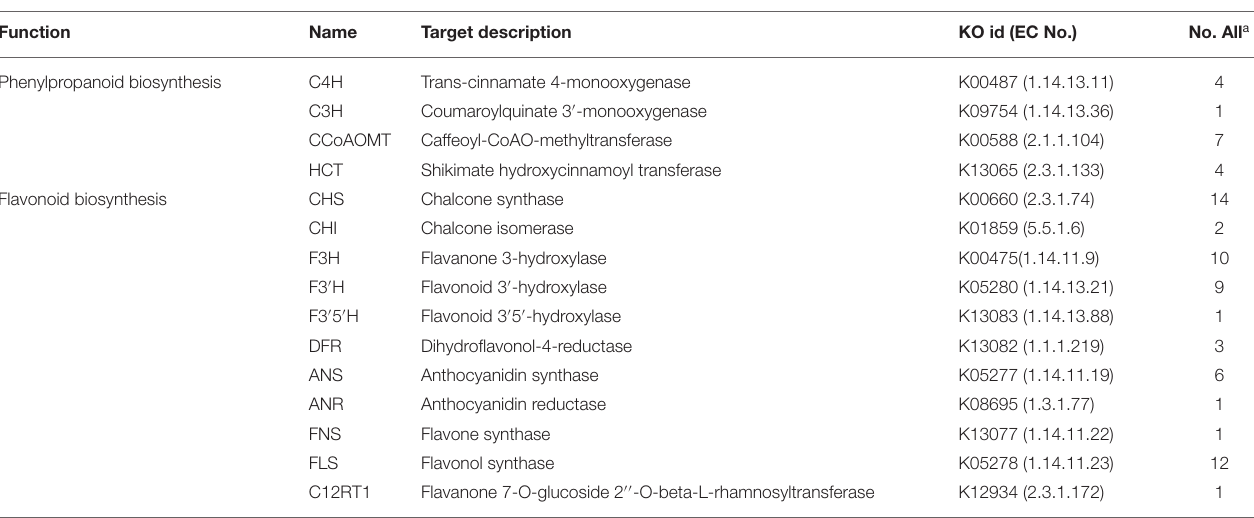
FIGURE 4 | Histogram of KEGG classification for different colours of C. kanran . Functional classification of differentially expressed unigenes, considering both purple-red and white C. kanran . Classification followed the KEGG annotations. The red star shows the category we focused on. TABLE 1 | Candidate genes related to flower pigmentation of Cymbidium kanran